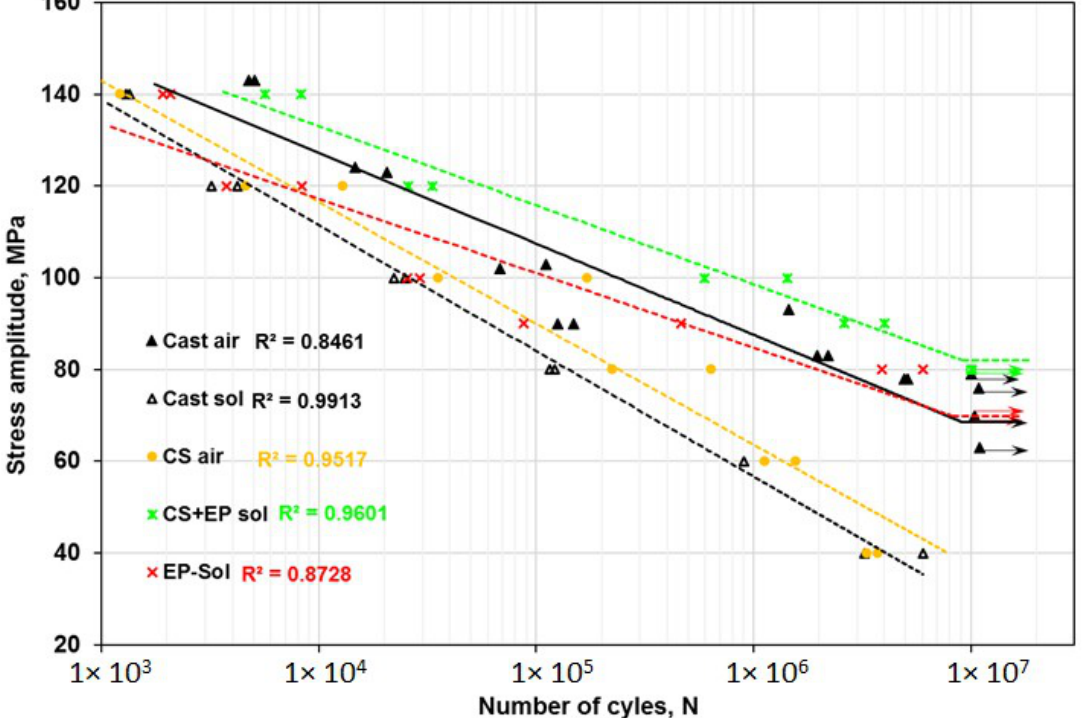
Figure 7. S-N curves show a comparison of fatigue life between the uncoated and coated AZ31B cast alloy tested in 3.5 wt.% NaCl solution. Note: EP-e-paint, Sol–3.5% NaCl solution and CS-cold spray.